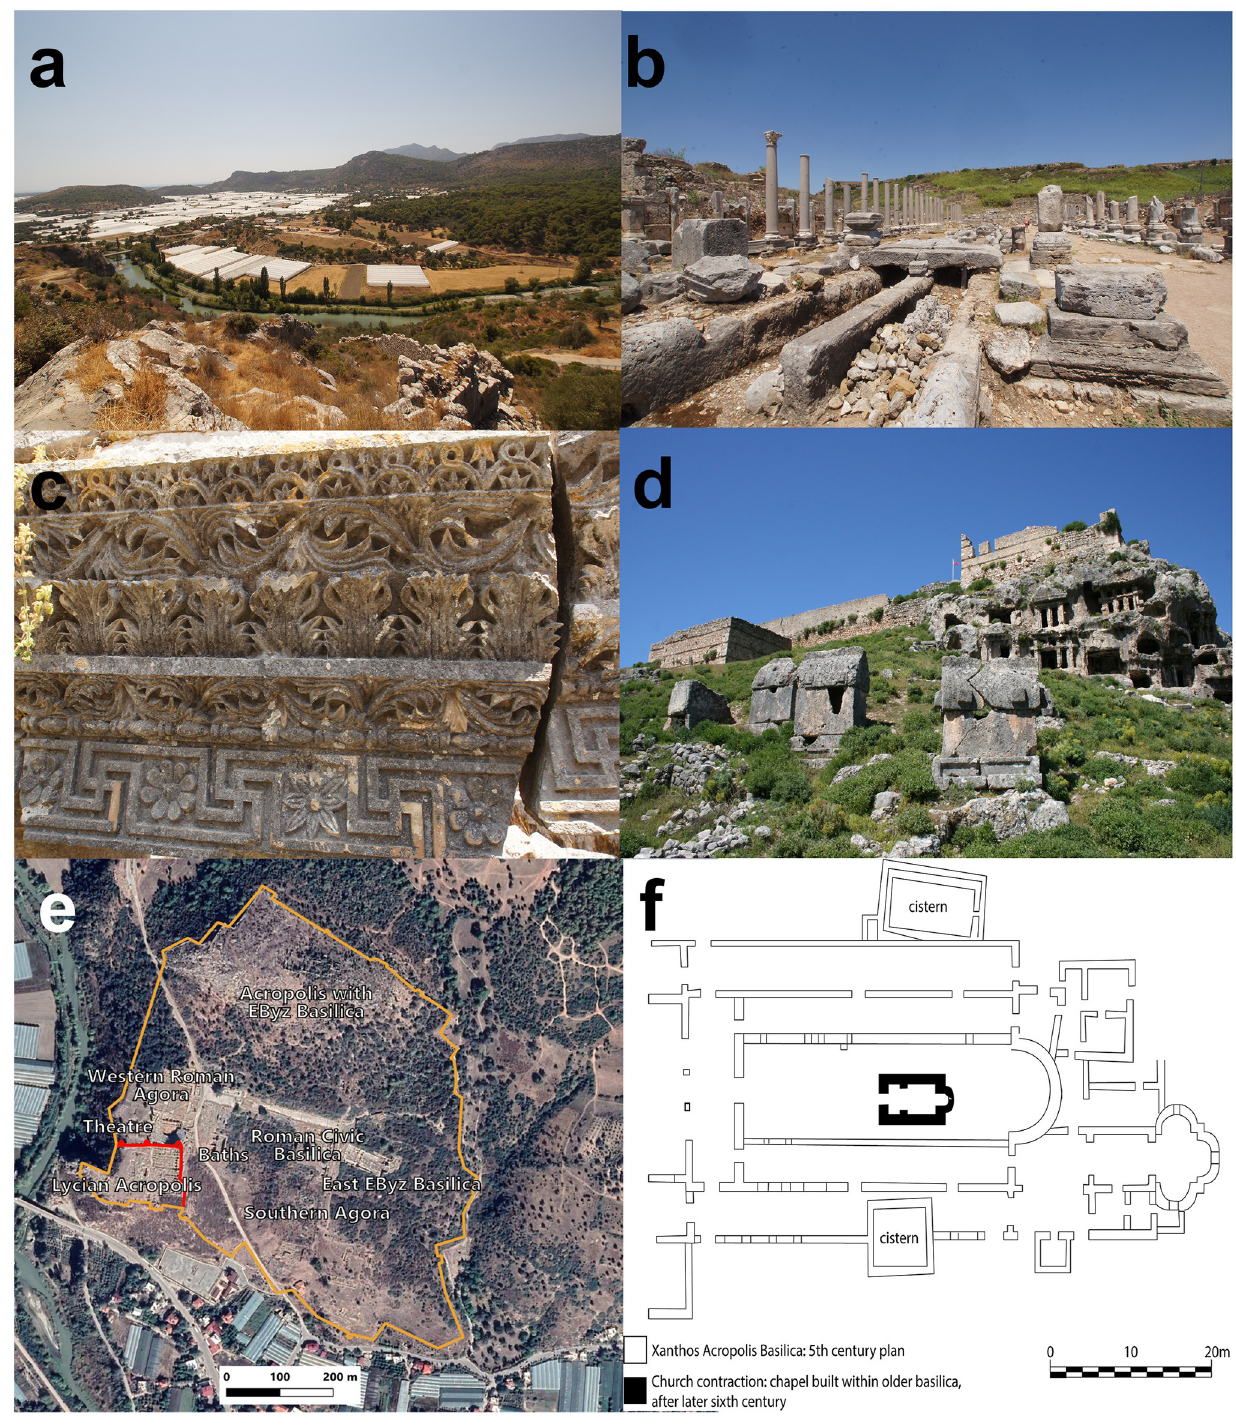
Fig 7. Site photographs and plans from Lycia-Pamphylia. All photographs and plans are by Jordan Pickett, excluding 7d. ( a ) A Lycian alluvial landscape, looking west over the river E ş en C¸ayı / anc. Xanthos from 7th-9th century Byzantine fortifications on the Lycian Acropolis at the city of Xanthos, with modern greenhouses below; ( b ) the Roman colonnaded street with cascading aqueduct-fed fountains at Perge; ( c ) Sixth century CE architectural sculpture from a church at Asarcık; ( d ) Tlos, with Roman stadium in the foreground, Iron Age-Hellenistic sarcophagi and tombs in the mid-ground, and Early- Middle Byzantine fortifications built atop the Iron Age acropolis (photograph by Hugh Elton); ( e ) Annotated satellite image of Xanthos, with Iron Age fortifications (in orange) and Middle Byzantine refortification of the Iron Age Lycian Acropolis (in red) added in QGIS; ( f ) plan of Middle Byzantine contraction of older church basilica on Xanthos Acropolis (after